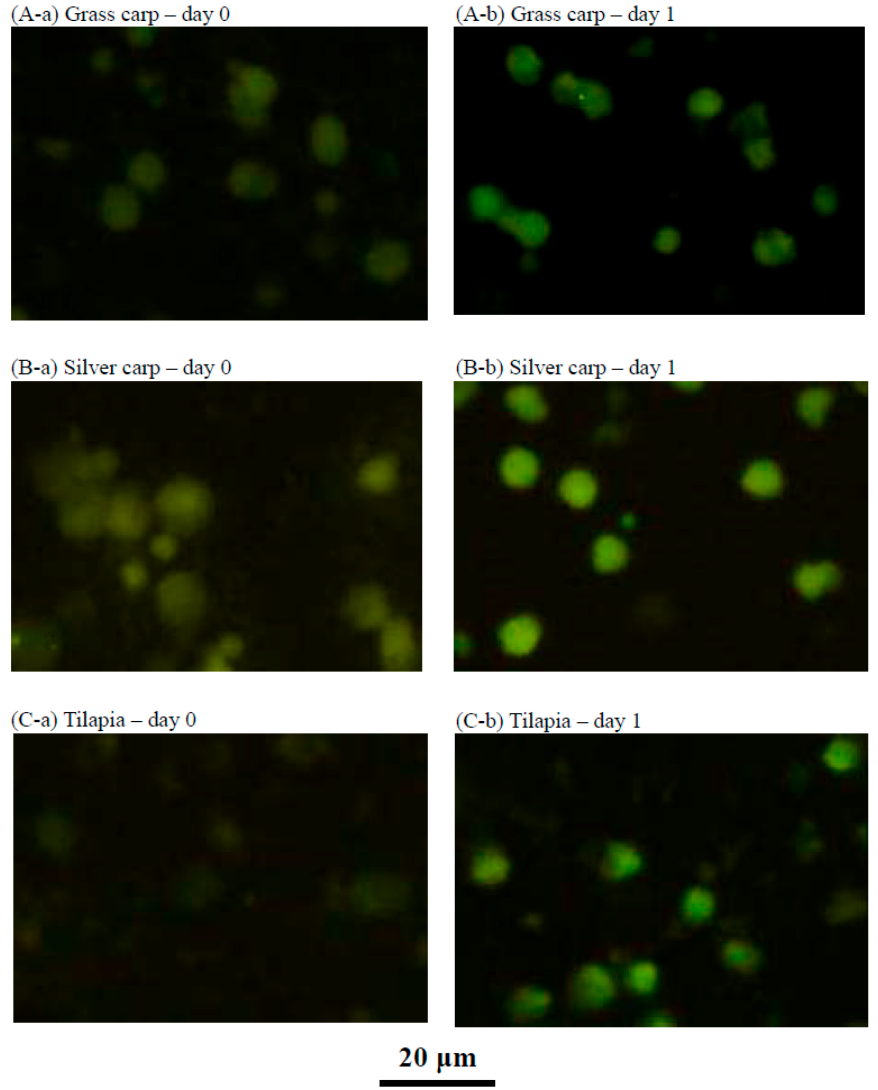
Figure 4. Immunofluorescent staining of the transferrin receptor of cells collected from suspension cultures of head kidney cells from ( A ) grass carp, ( B ) silver carp, and ( C ) tilapia at day zero and day one. At day 0, virtually no cells were immunofluorescently stained in the three fish species, as shown in ( A - a ), ( B - a ), and ( C - a ). At day one, various cells were immunofluorescently stained, representing newly proliferated RBC cells in stages 1, 2, and 3, as shown in ( A - b ), ( B - b ), and ( C - b ). 2.5. Isolation of the Active Substance in Fish Serum That Stimulates the Proliferation of Fraction 1 Cells in